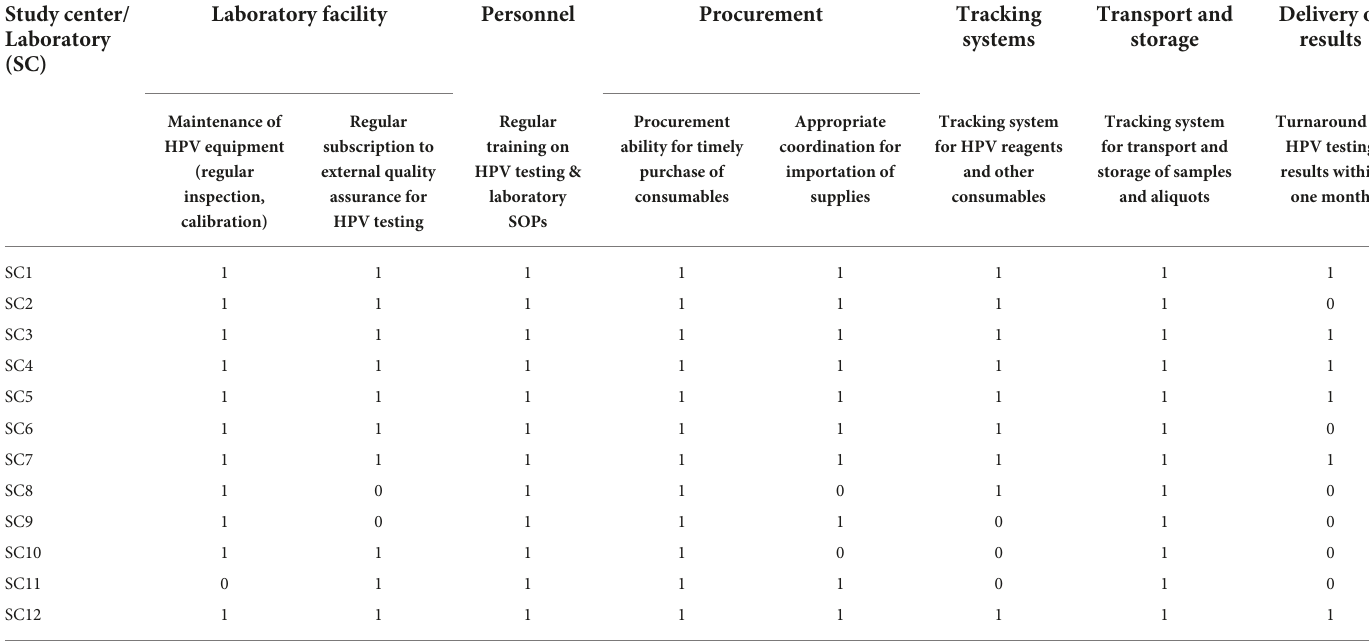
TABLE 2 Continuity capacity of laboratories based on compliance (1 = complied, 0 = not complied) to 8 continuity